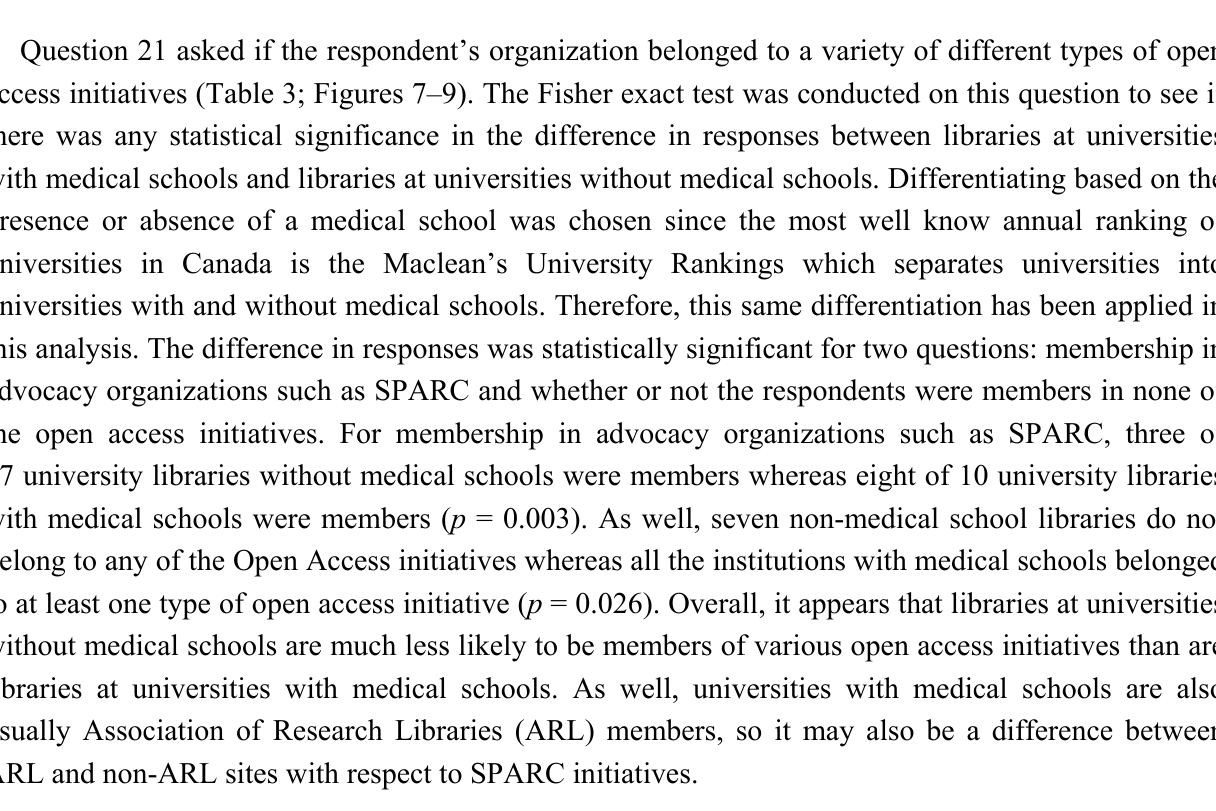
Figure 7. Membership in OA publisher